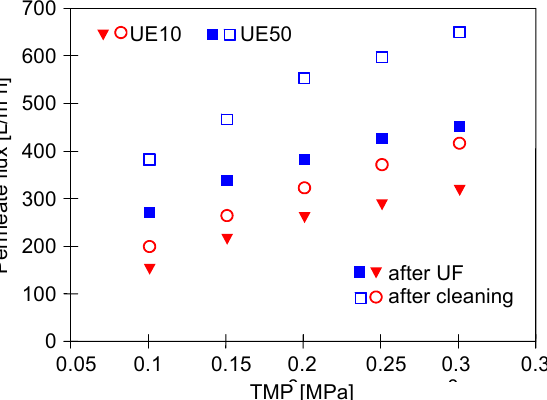
Figure 8. Changes in the permeate flux during UF of white solution and white+wax mixture. R—modules rinsing with water. TMP = 0.2 MPa, feed flow velocity: 1 m/s.